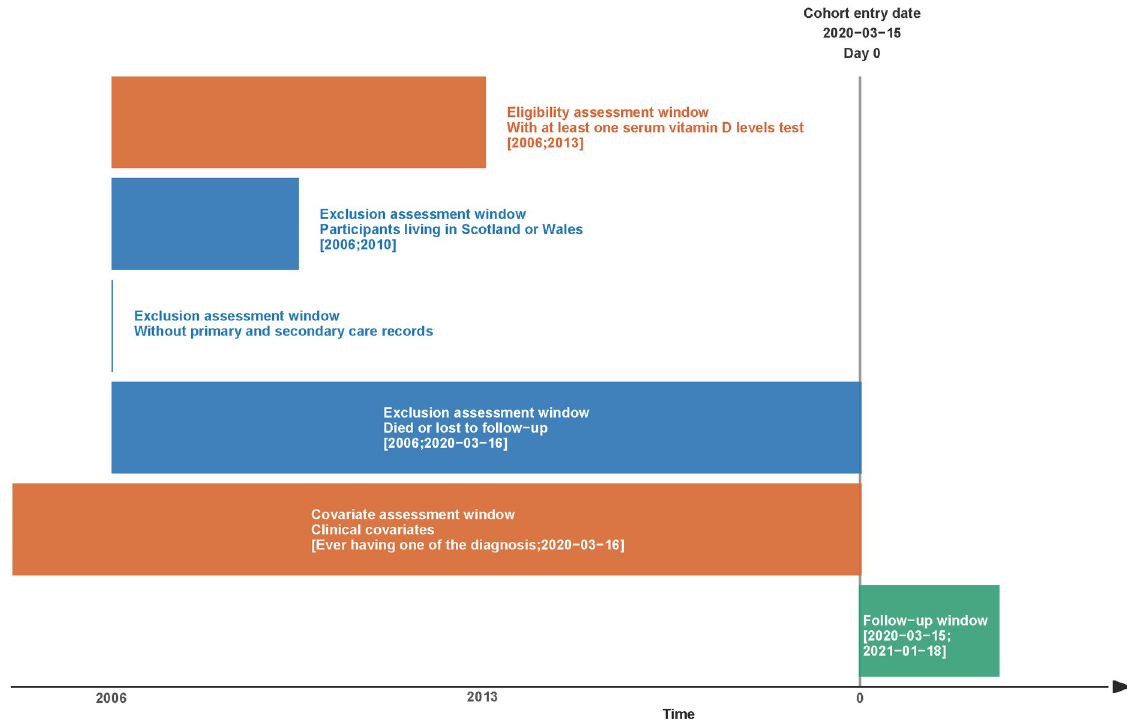
Fig 1. Graphical depiction of the inclusion and exclusion criteria, cohort entry date and follow-up period.